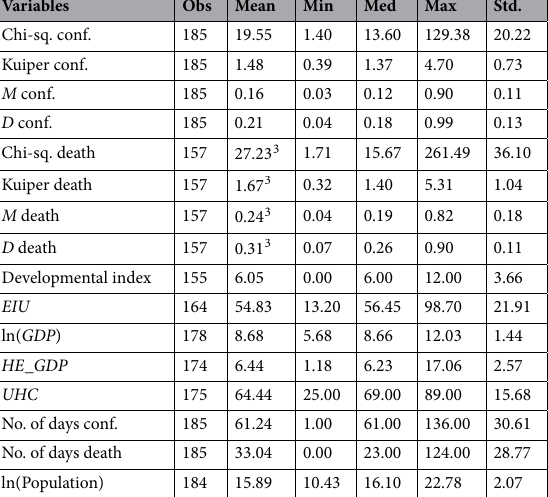
Table 1. Descriptive statistics. The table presents the mean values of the goodness-of-fit measures (Chi- square, Kuiper, M , D ) for the cumulative number of confirmed and death cases, the developmental index and its components ( EIU , ln( GDP ), HE _ GDP , UHC ), and other variables. The unit of observation is a country. The number of observations vary due to missing values. 3 indicates significance of the difference in means between confirmed and death cases at the 1% level.